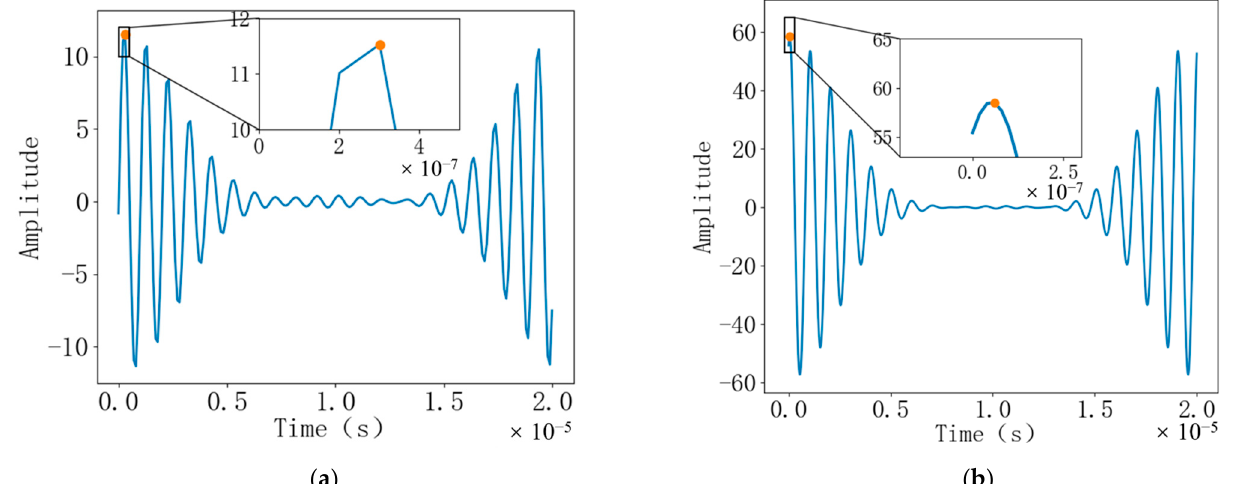
Figure 9. ( a ) When the sampling rate is 10 times the signal frequency, the time-domain output of the cross-correlation function; ( b ) When the sampling rate is 50 times the signal frequency, the time-domain output of the cross-correlation function.